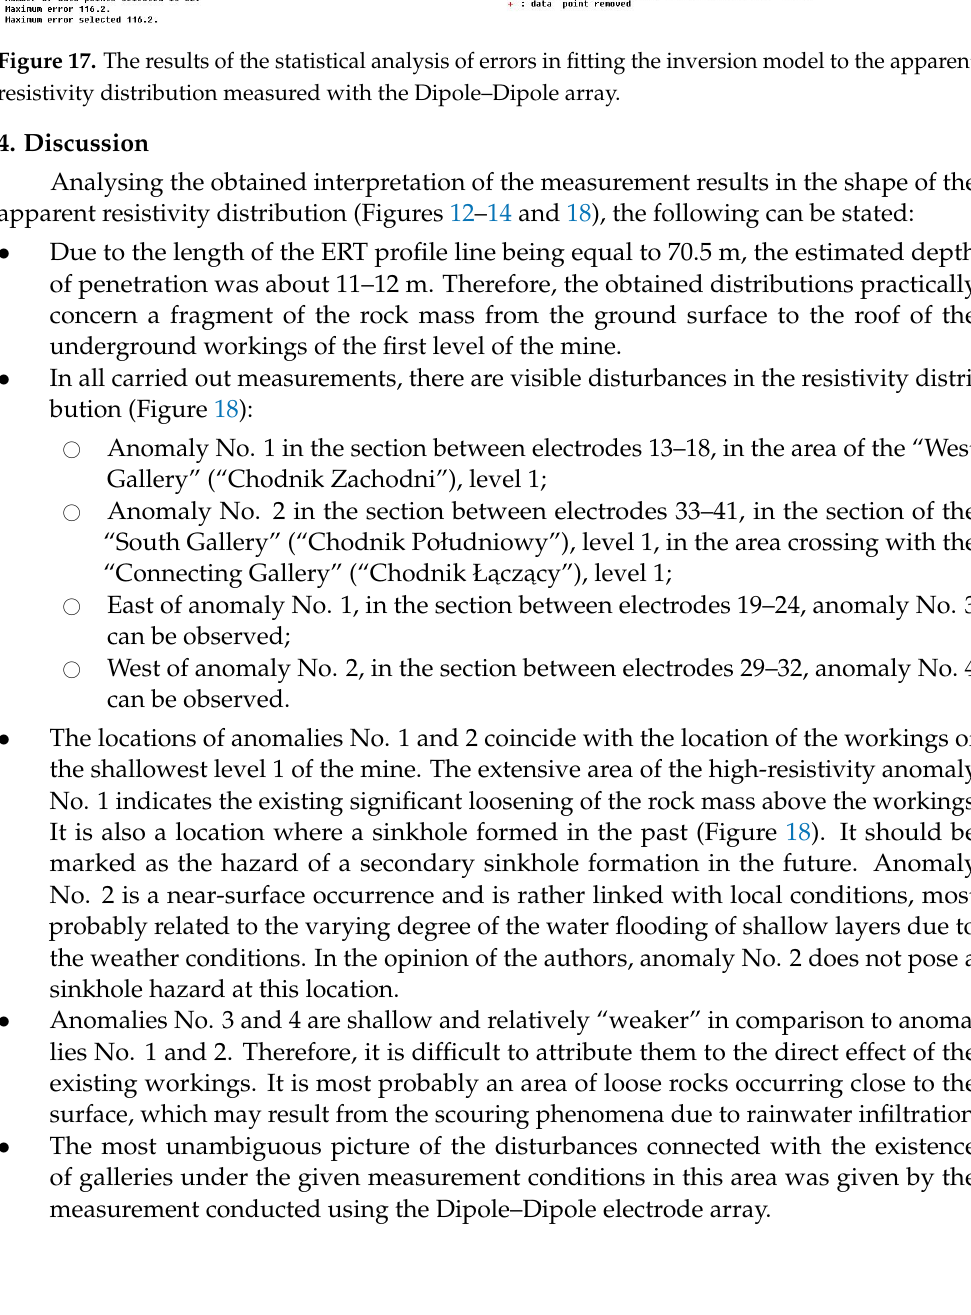
ent resistivity distribution measured with the Dipole–Dipole array. resistivity distribution measured with the Dipole–Dipole